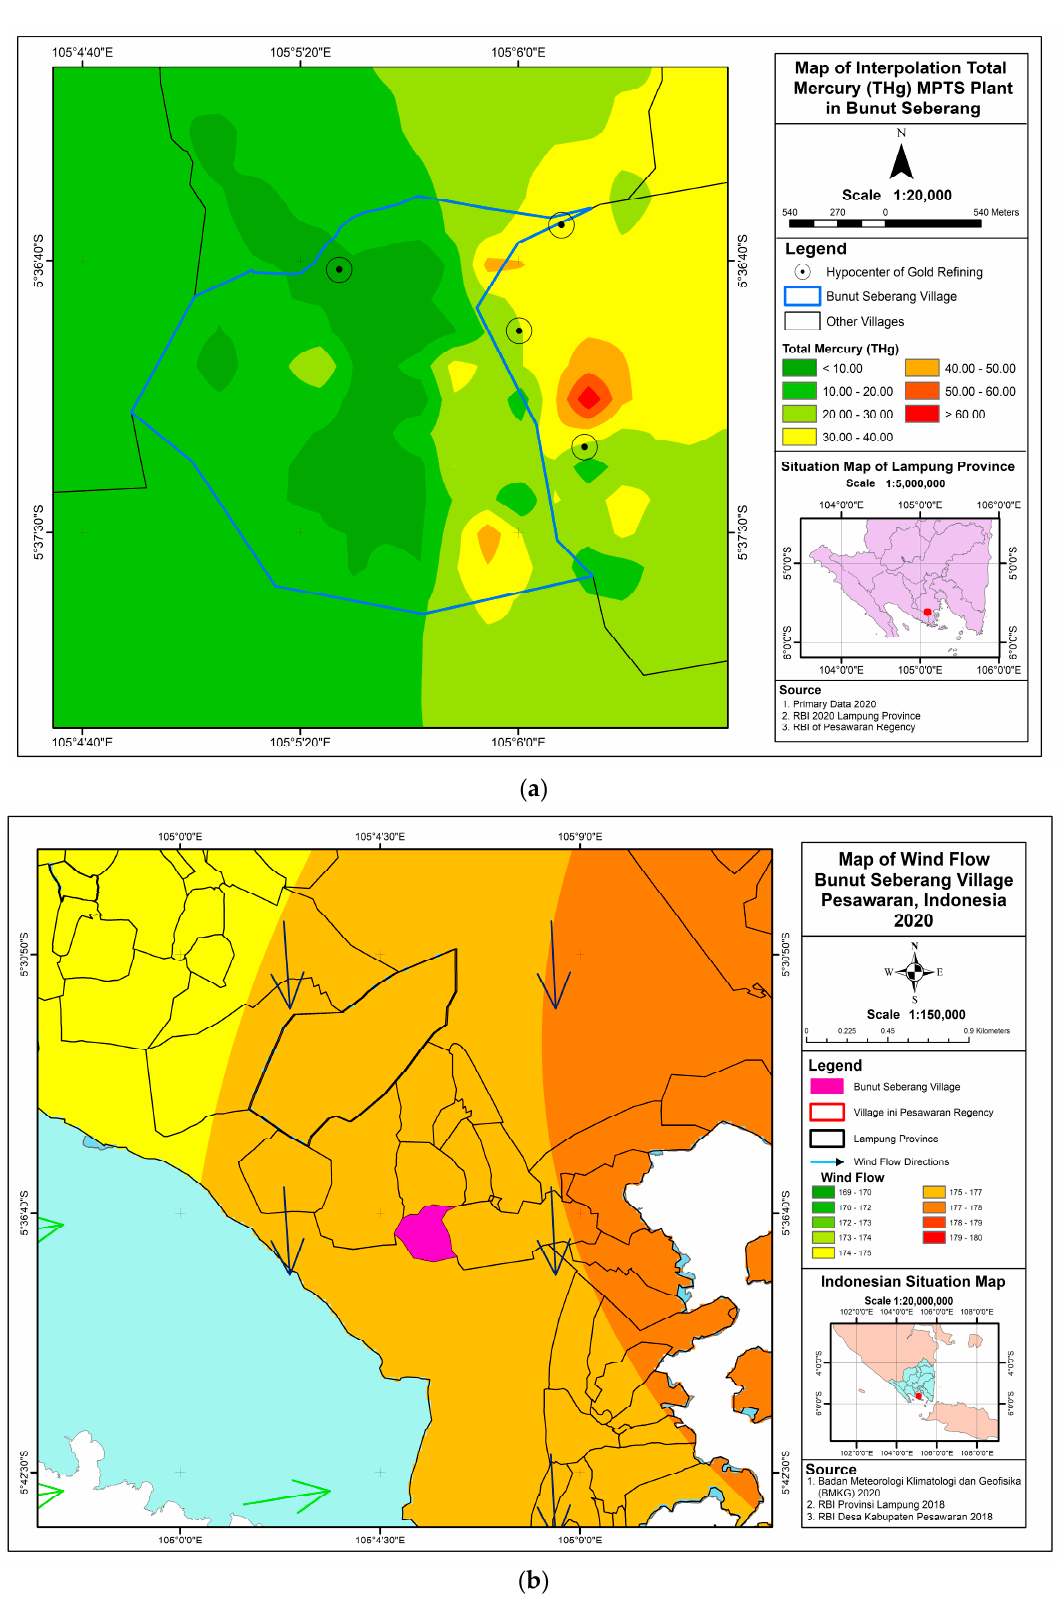
Figure 6. Map situation of Bunut Seberang Village: ( a ) interpolation of THg in atmospheric with tree barks as bioindicators; ( b ) map of wind and flw at Bunut Seberang